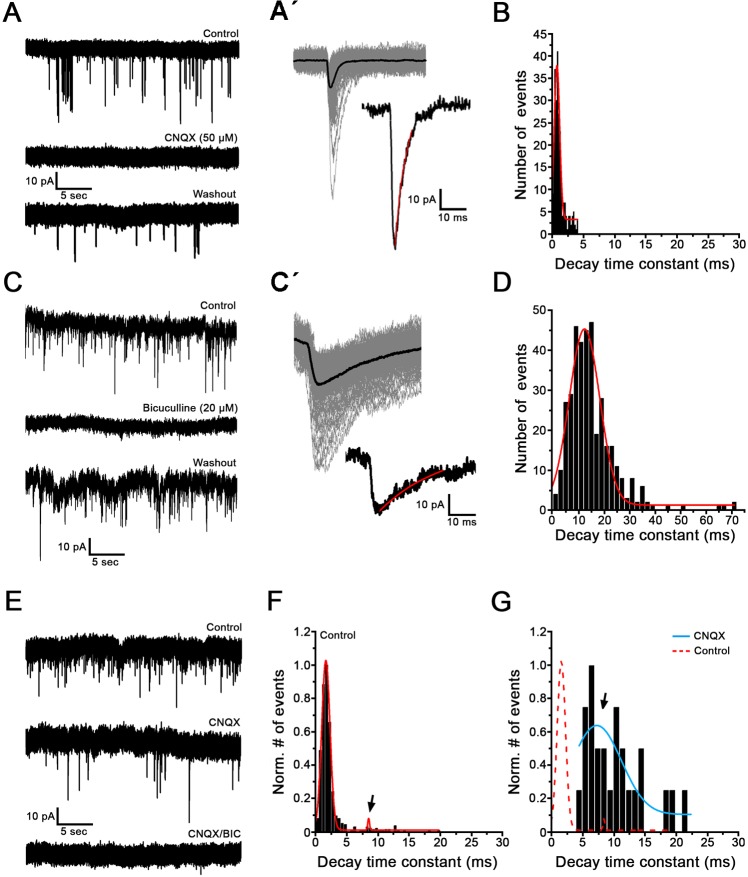
Human NPs display glutamatergic and GABAergic spontaneous synaptic transmission in vitro (Days 90–167).Voltage clamp recordings of spontaneous synaptic currents from ChR2- neurons. Holding potential -90 mV; at room temperature. (A) Example recording showing that in this cell, spontaneous synaptic currents are completely and reversibly blocked by 50 μM CNQX, a glutamate receptor blocker. (Aʹ) Top left panel shows a superimposed view of synaptic events from recording in A at an enlarged time scale (gray traces, n = 122 events). Average trace is shown in black. Bottom right panel shows an example of one postsynaptic event. Red line indicates monoexponential fit used to calculate the decay time constant. (B) Distribution of decay time constants for the recording shown in A, with a peak of the distribution at 0.79 ms. (C) Example recording showing that in this cell, spontaneous synaptic currents are completely and reversibly blocked by 20 μM Bicuculline, a GABA-A receptor blocker. (C´) Postsynaptic events from recording in C (n = 131 events, gray lines) were superimposed and averaged (black trace, top left). Bottom right panel shows an example of one postsynaptic current with monoexponential fit of decay time constant. (D) Distribution of decay time constants of the recording shown in C, with a peak of the distribution at 15 ms. Note that events at these inhibitory synapses appear as excitatory postsynaptic currents in this type of recording, as the reversal potential of chloride has been changed in the artificial in vitro recording environment. (E) Example recording showing a mix of glutamatergic and GABAergic synaptic events during spontaneous activity. In this cell, CNQX only partially abolished postsynaptic events (middle trace). The remaining events are blocked by bicuculline (bottom trace). (F) Distribution of decay time constants of postsynaptic events from the control trace before drug application in E shows a distribution with two peaks, at 1.6 ms and 8.5 ms (arrow). (G) Distribution of decay time constants of postsynaptic events during CNQX application for the recording shown in the middle trace in E. Note that compared to the distribution in F, the peak at 1.6 ms is abolished in CNQX (red dotted line); therefore it is representing the glutamatergic postsynaptic events. The blue line represents the events that are not blocked by CNQX, but sensitive to bicuculline, and therefore GABAergic. The arrow points to the same peak as in F, now appearing larger due to rescaling.